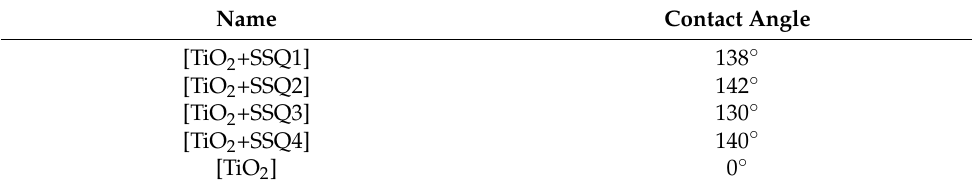
Table 5. Contact